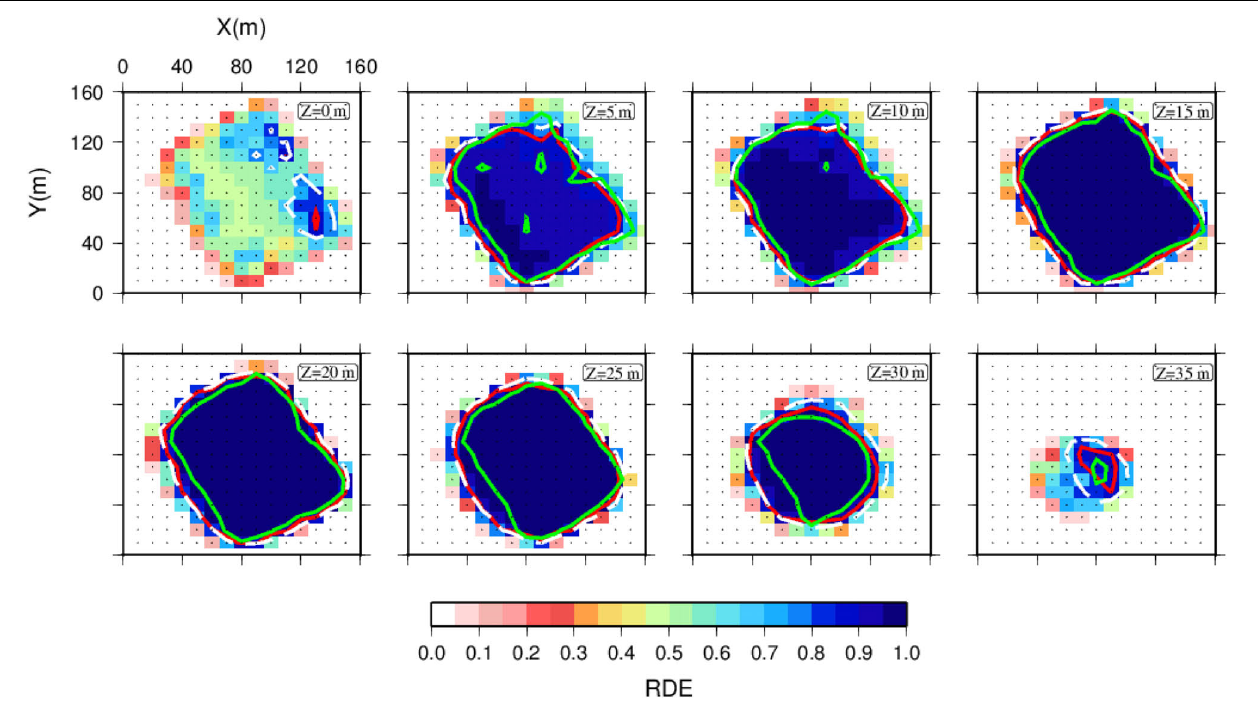
FIGURE 8 | Diagonal elements of the resolution matrix (RDE) of the 3D attenuation model obtained with the parameterization 10 m 3 × 10 m 3 × 5 m 3 . The RDE is represented at each inverted depth. The contours represents the threshold values of RDE (red) Sj (white) and DWS (green) chosen in order to obtain a similar contour, binding the RDE to be higher than 0.85 (see Supplementary Figures S8, S9 ).